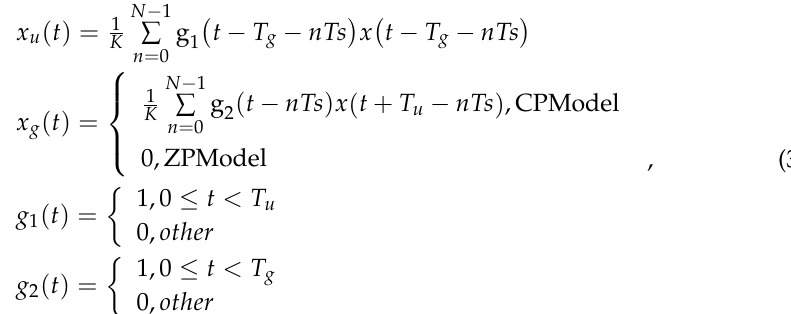
x t represents the protec- g